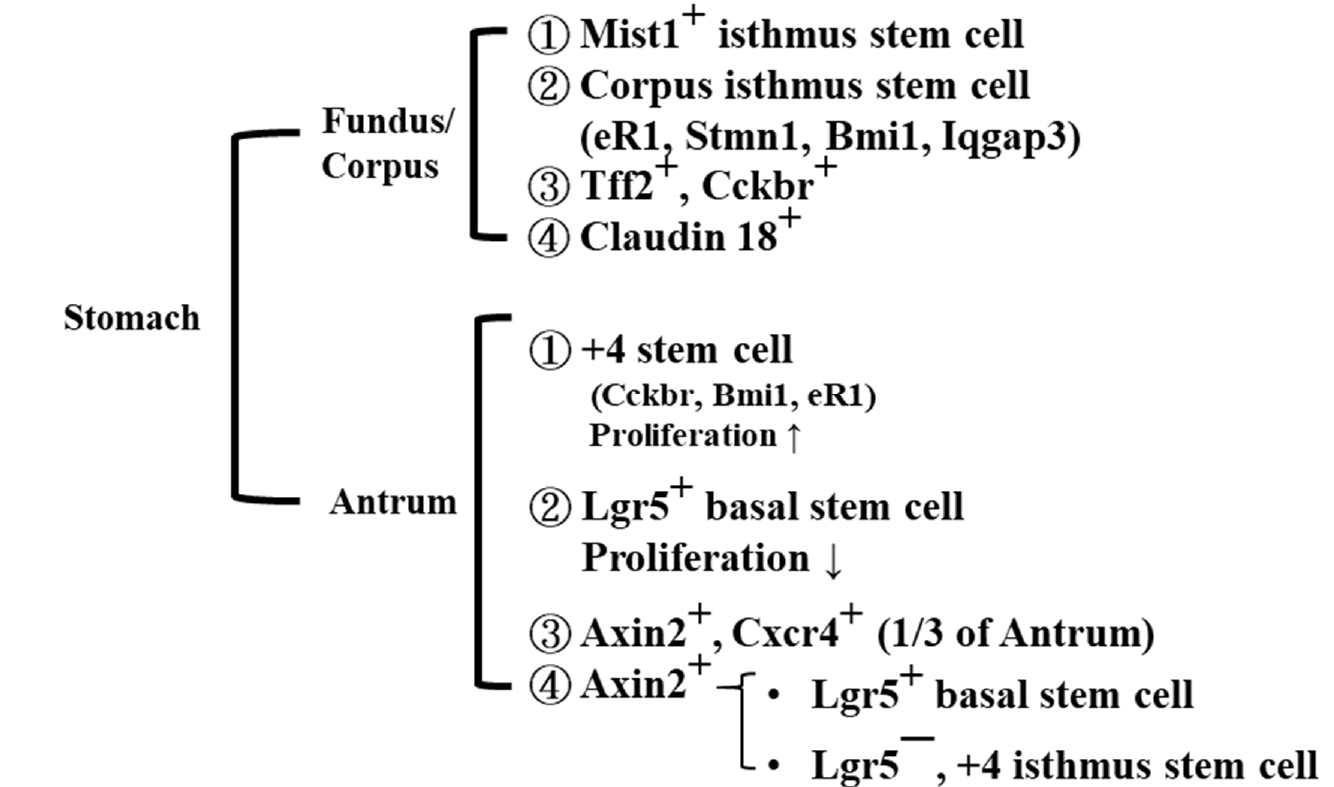
Figure 1. Representative stem cells are grouped in the stomach. Stem cells in both the antrum and fundus/corpus were assigned by the specific biomarkers as defining the stem cells, and these stem cells and progenitor cells can be mutations of the oncogene and the tumor suppressor genes to induce the neoplasia program.